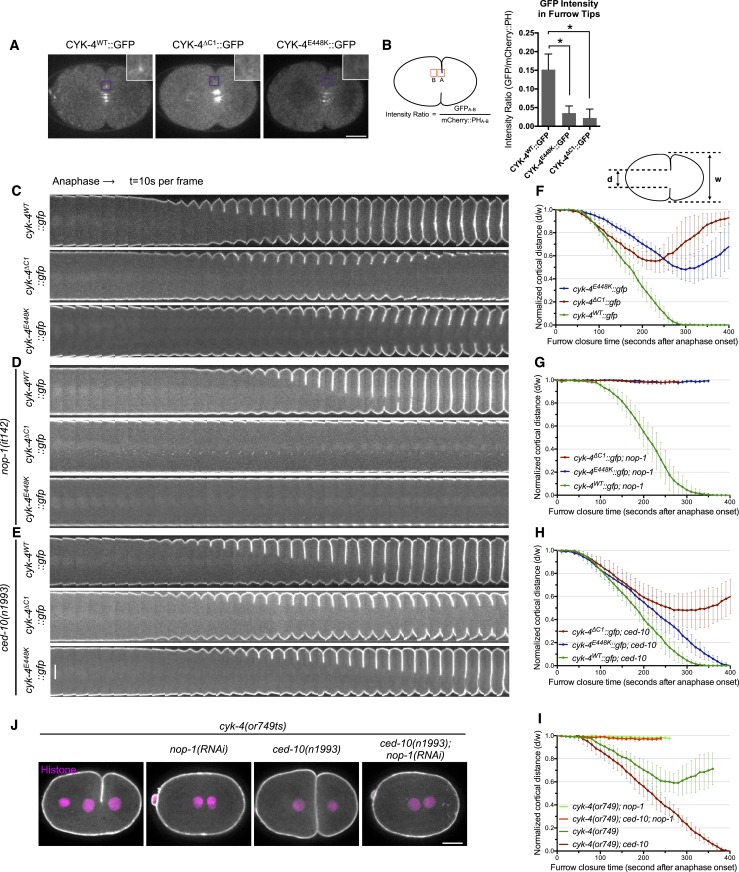
CYK-4-dependent membrane binding promotes furrow ingression.(A) CYK-4 accumulates on the plasma membrane. Membrane accumulation is observed on ingressing cleavage furrows (boxed regions). CYK-4 membrane accumulation requires the C1 domain and is compromised by the E448K substitution in the cyk-4(or749ts) allele. (B) Membrane accumulation of CYK-4 variants. The accumulation was quantified as a ratio of the accumulation of CYK-4::GFP/mCherry::PH at the furrow tip as depicted in the schematic; the mean intensity ±s.e.m. are plotted. (N = 8–12 embryos *p < 0.05, one way ANOVA followed by Tukey multiple comparison). (C) Deletion of the C1 domain and the E448K substitution impair cleavage furrow ingression. Kymographs generated from time-lapse recordings of the equatorial region of embryos of the indicated genotypes expressing the membrane marker mCherry::PH. Kymographs begin at anaphase onset. (D) Deletion of the C1 domain and the E448K substitution abrogate centralspindlin-dependent furrow ingression. The progression of cytokinesis was assessed in embryos expressing CYK-4 variants in combination with a loss of function mutation in nop-1. (E) Mutation of CED-10/Rac1 slightly increases furrow ingression in CYK-4∆C1 embryos and allows complete, albeit delayed, furrow ingression in CYK-4E448K embryos. The progression of cytokinesis was assessed in embryos expressing CYK-4 variants in combination with a loss of function mutation in ced-10. (F–I) Quantification of furrow ingression rates in embryos of the indicated genotypes. Representative examples are shown in the accompanying kymographs. (N = 8–12 embryos; error bars, 95% confidence intervals). (J) The ability of ced-10/Rac1 to rescue cytokinesis in CYK-4E448K embryos requires the NOP-1 pathway for furrow ingression. Images shown reflect the maximal extent of furrow ingression in embryos of the indicated genotypes expressing the membrane marker mCherry::PH. Unless otherwise specified, all scale bars in all figures are 10 µm.